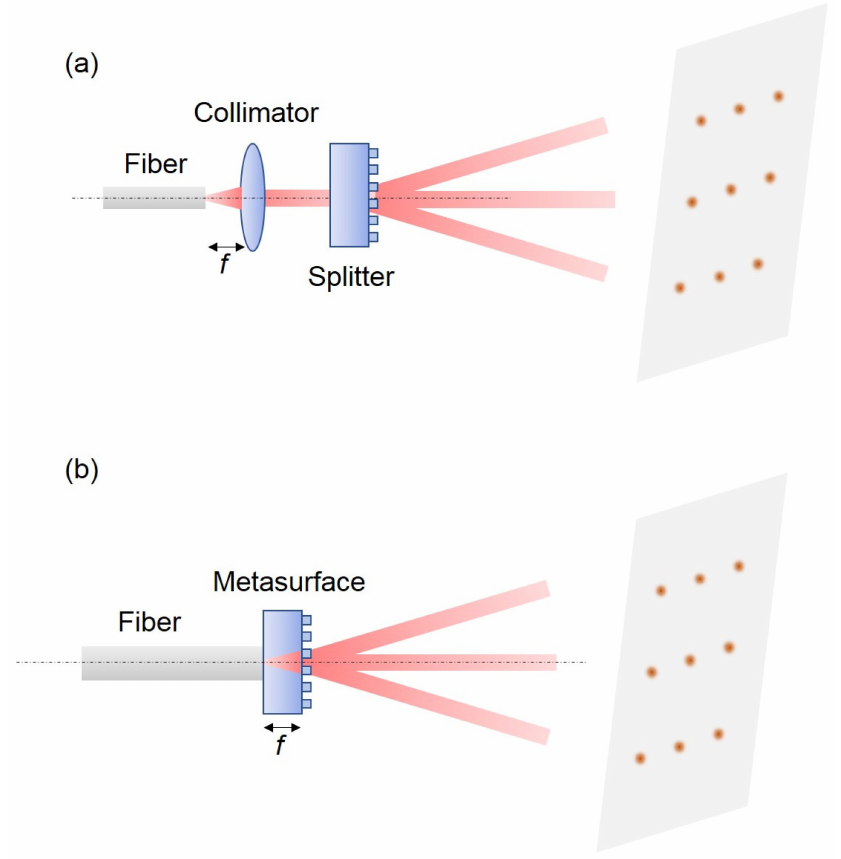
Figure 1. The concept of the all-in-one collimating splitter based on metasurfaces. ( a ) Schematic of the traditional configuration. ( b ) Schematic of the proposed all-in-one collimating